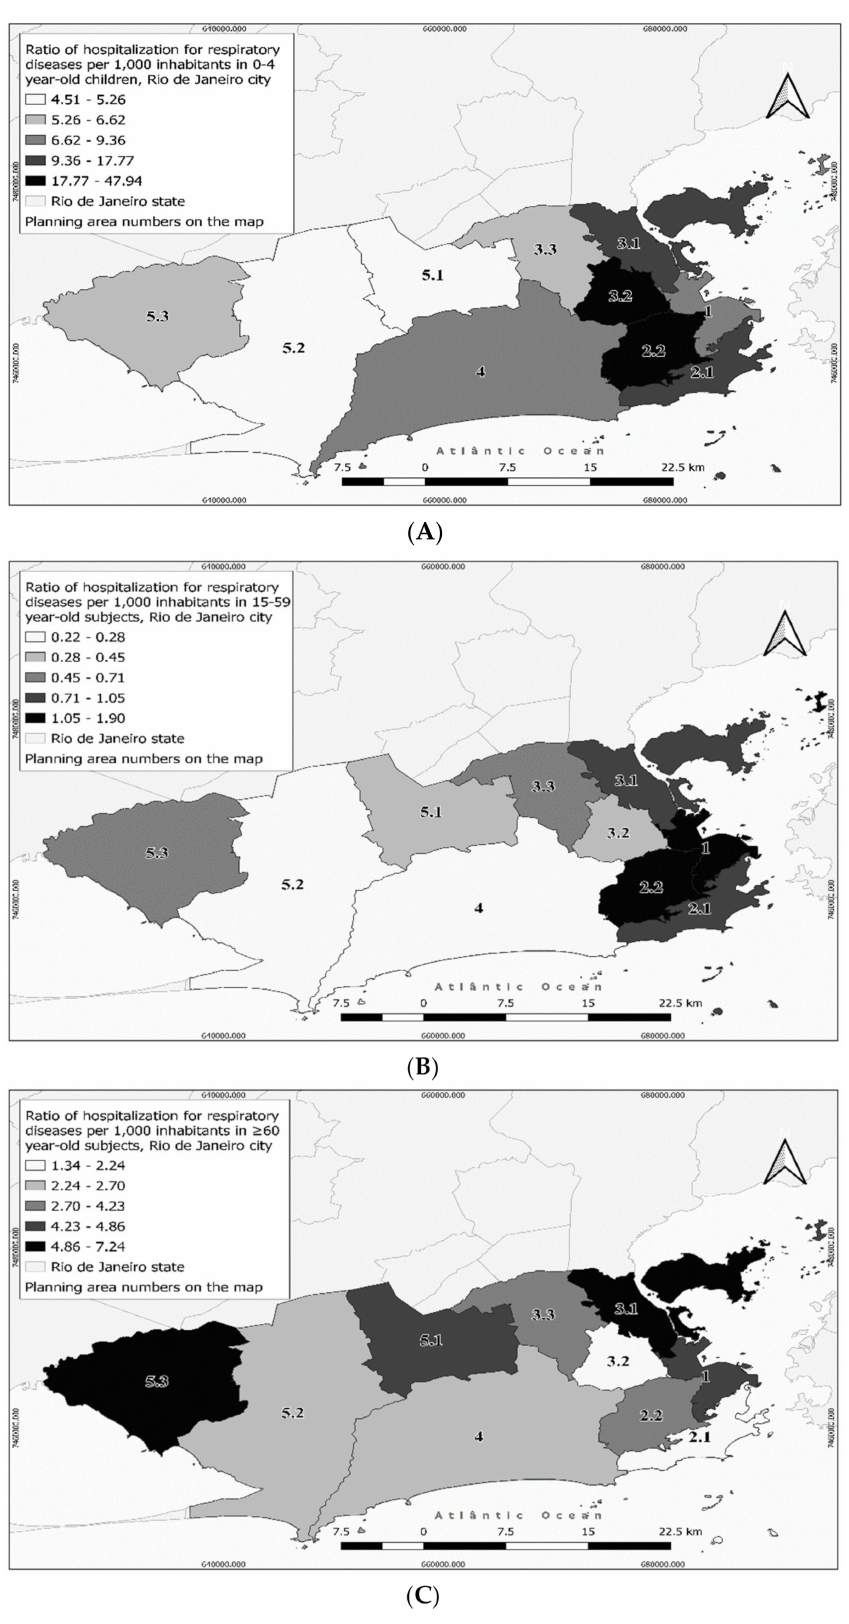
Figure 3. Ratio of respiratory hospitalizations in the city of Rio de Janeiro in 2013–2017: ( A ) 0–4